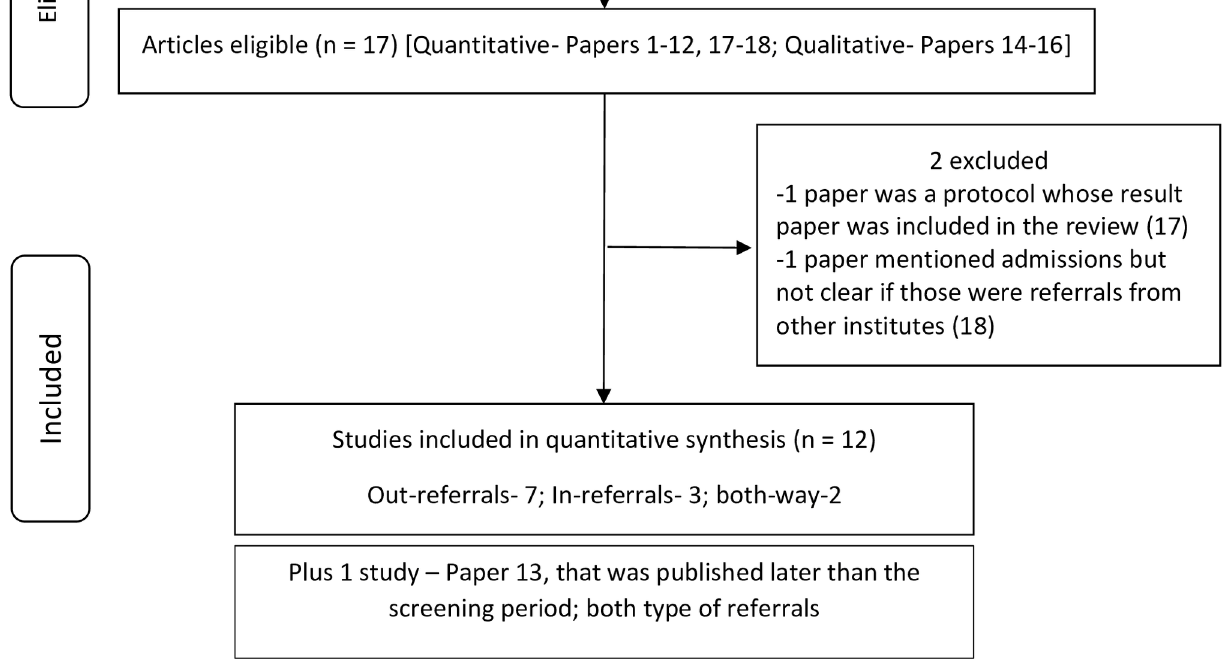
PLOS ONE | DOI:10.1371/journal.pone.0159793 August 3,